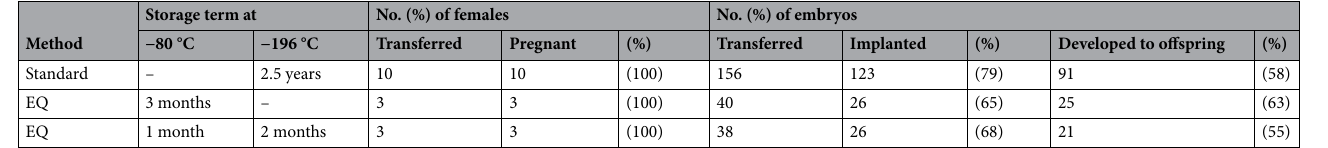
Table 4. Full-term development of embryos fertilized in vitro using spermatozoa frozen by the standard method and stored for 2.5 years or by the EQ method and stored for 1–3 months. There were no significant differences in the implantation or birth rates between the groups by Fisher’s exact test.